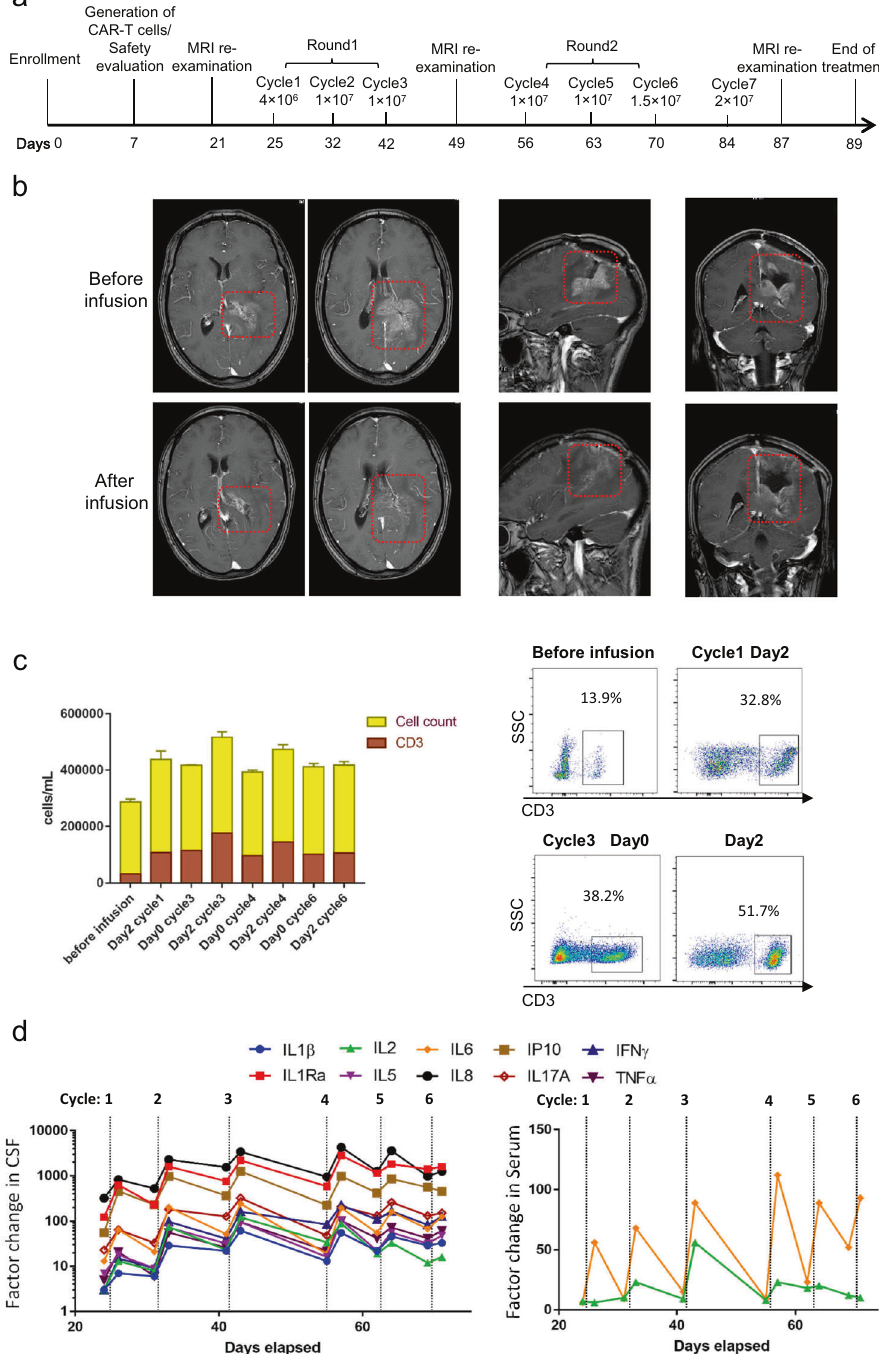
Fig. 1 Treatment overview. a The schedule of two rounds of intracranial infusion of B7-H3 targeted CAR-T cells. The intracranial infusion was interrupted for 1 week after each round for assessment of safety and disease. Since the patient requested to be discharged 5 days after cycle 6 infusion and dropped out of the clinical study after cycle 7 infusion, further analysis of CAR-T therapy and resistance of post-therapy were limited. b Coronal, sagittal, and axial MRI of the brain before and after the fi rst 3-cycles CAR-T cells infusion (day 21 and 49). Red dotted box highlighted the site of the resected tumor region. c Total nucleated cell and T cell count in the CSF, obtained from the delivery device before and after the infusion cycle 1, 3, 4, and 6. The results showed the mean values of triplicate technical repeats. Flow cytometry analysis of the T cell ratio in total nucleated cell indicated that expansion of T cells after delivery of CAR-T cell. d The signi fi cant cytokines changes in CSF and serum before and after each cycle infusion